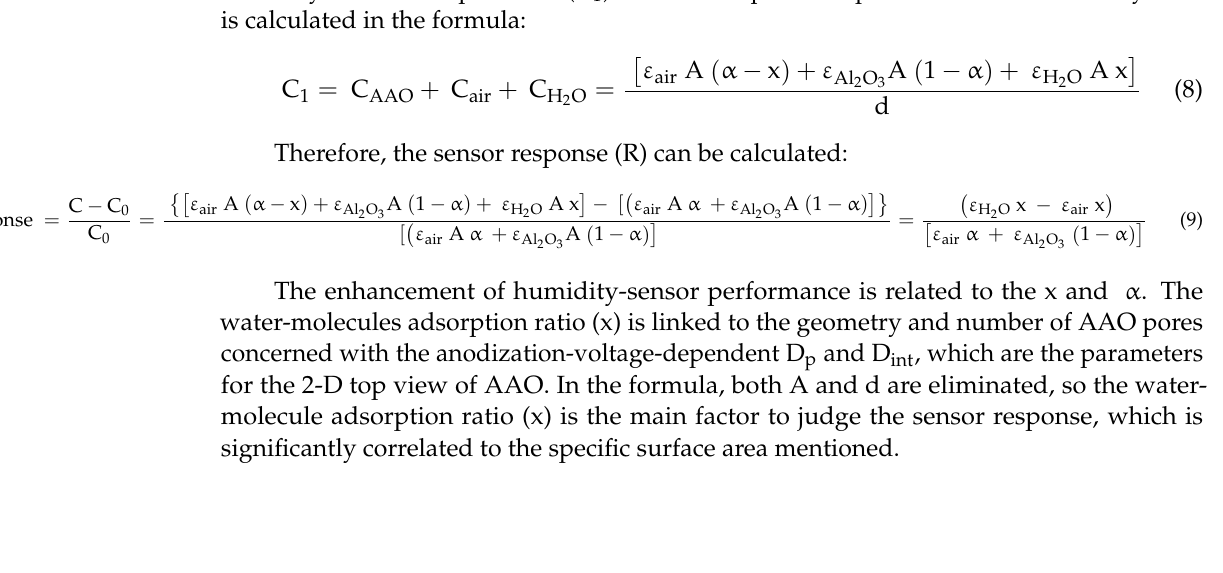
Figure 15, a schematic diagram of water-molecule adsorption [59]. The sensor response R is an important indicator of a capacitive sensor and defined as in Formula